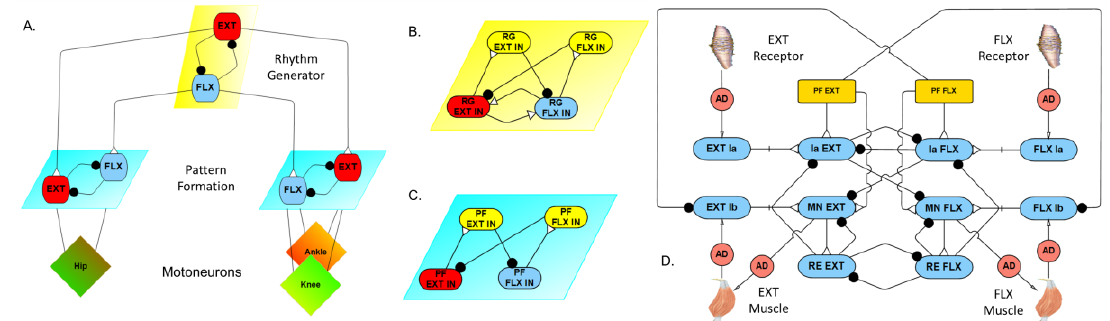
Figure 4. Synthetic nervous system. ( A ) Single limb control hierarchy. ( B ) Rhythm generator configuration. ( C ) Pattern formation network. ( D ) Sensory-motor network. AD: Adaptor; EXT: Extensor; FLX: Flexor; IN: Interneuron; PF: Pattern formation; RE: Renshaw cell; RG: Rhythm generation.